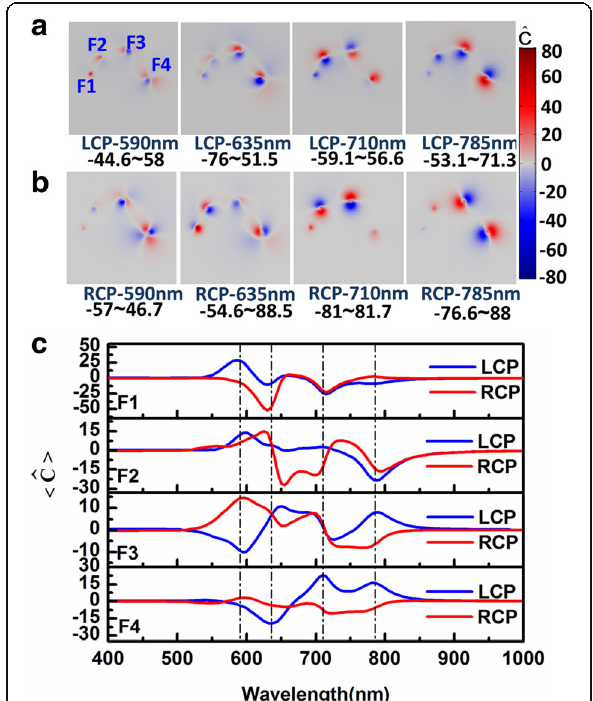
Fig. 6 The optical chirality enhancement factors of the chiral silver particles chain on a gold film. a Chiral near-field enhancement distributions at the middle of the gap between particle-film in x - y plane at different resonant peaks for LCP light and b for RCP light. c Volume-averaged optical chirality enhancement factors in the gaps F1, F2, F3, and F4. The blue and red solid lines correspond to LCP and RCP light, respectively. The vertical dashed lines from left to right correspond to the peaks at 590, 635, 710, and 785 nm, respectively